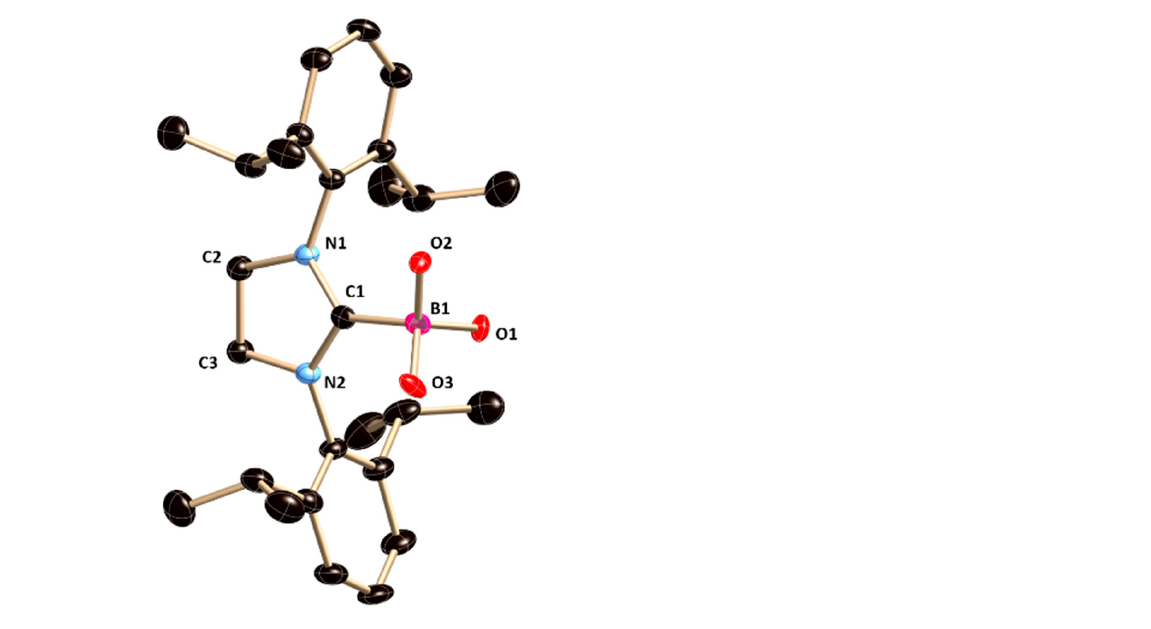
Figure 3. The molecular structure of 3 . Hydrogen atoms are omitted for clarity. Selected bond lengths [Å] or angles [deg]: N1–C1 1.316(4), N2–C1 1.337(4), C2–N1 1.471(4), C3–N2 1.478(4), C1–B1